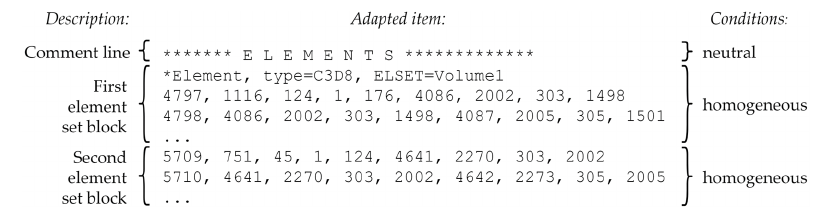
Figure 14. Adapted, compatible element sets for an error-free import into Z88.